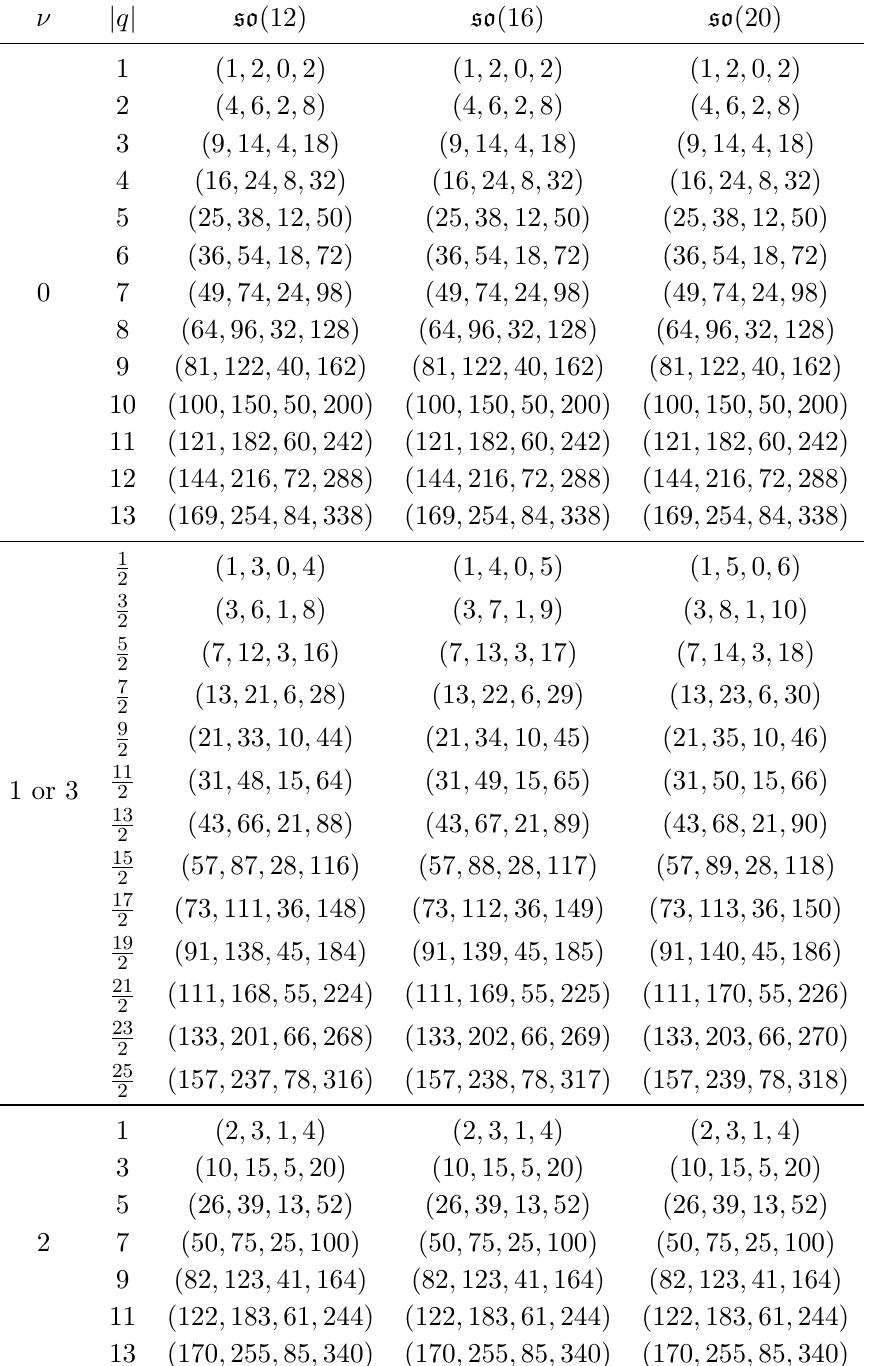
Codimension-two orders of vanishing of (ˆ x, ˆ y, ˆ z, ˆ w ) for various pseudo-charges q of so (4 k ) ⊕ u (1) vector matter. This matter is supported at I ∗ s using the constructions in equations (8.43) and